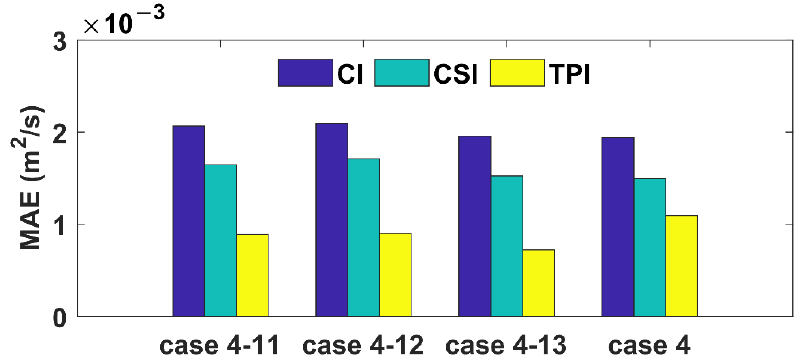
Figure 10. The MAEs between the prescribed and inverted VEVCs after using different distributions of wind stress drag coefficients to Cases 4-11, 4-12, 4-13, and 4.